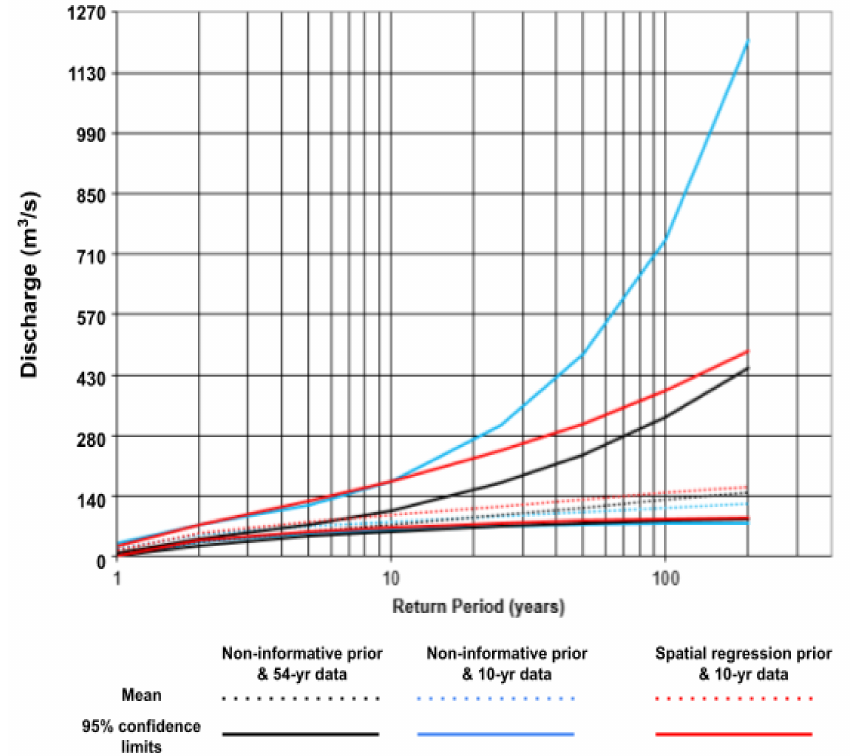
Figure 4. The means and 95% confidence limits for the three scenarios: non-informative prior and 54-year data, non-informative prior and the last 10-year data, and spatial regression prior and the last 10-year data.